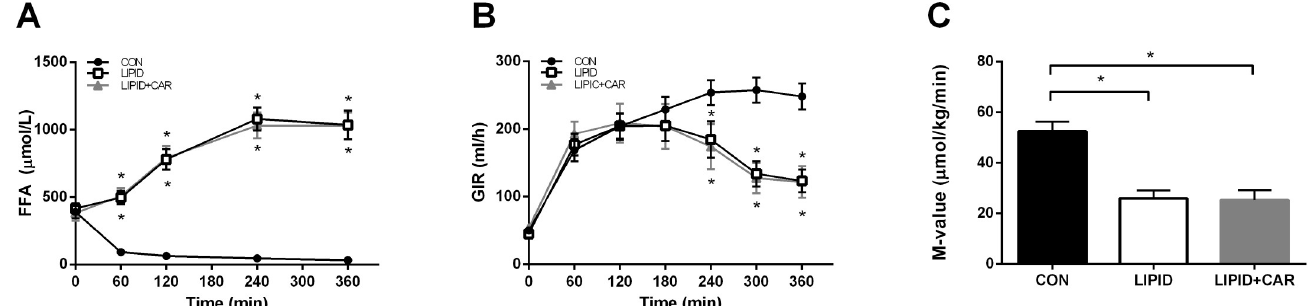
Fig 2. Hyperinsulinemic-euglycemic clamp. Plasma FFA concentrations (A), glucose infusion rates (B) and insulin sensitivity expressed as M-value (C) in CON, LIPID and LIPID+CAR during the hyperinsulinemic-euglycemic clamp (n = 8). Data are expressed as mean + SEM. � , Significantly different from CON ( P < 0.05).